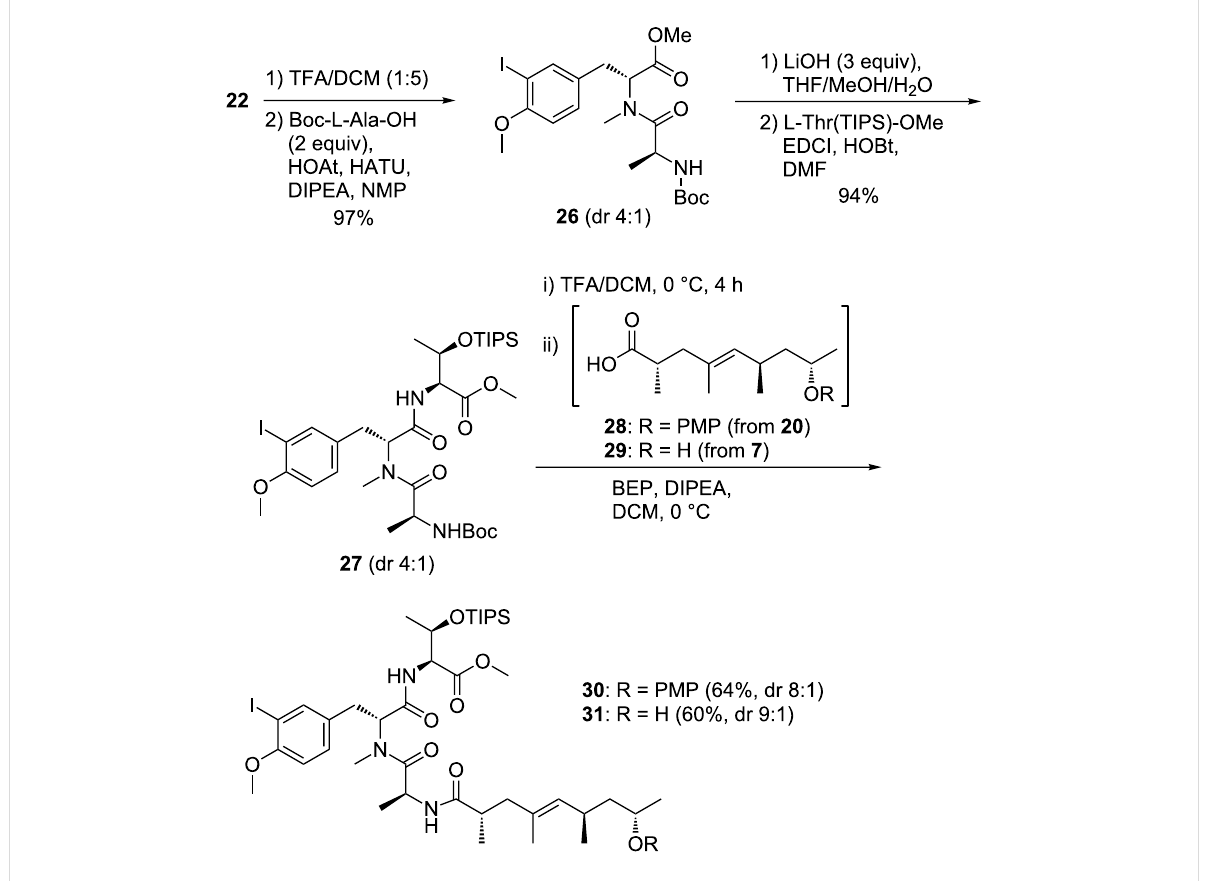
Scheme 5: Synthesis of the doubly protected open chain peptide-polyketide 31